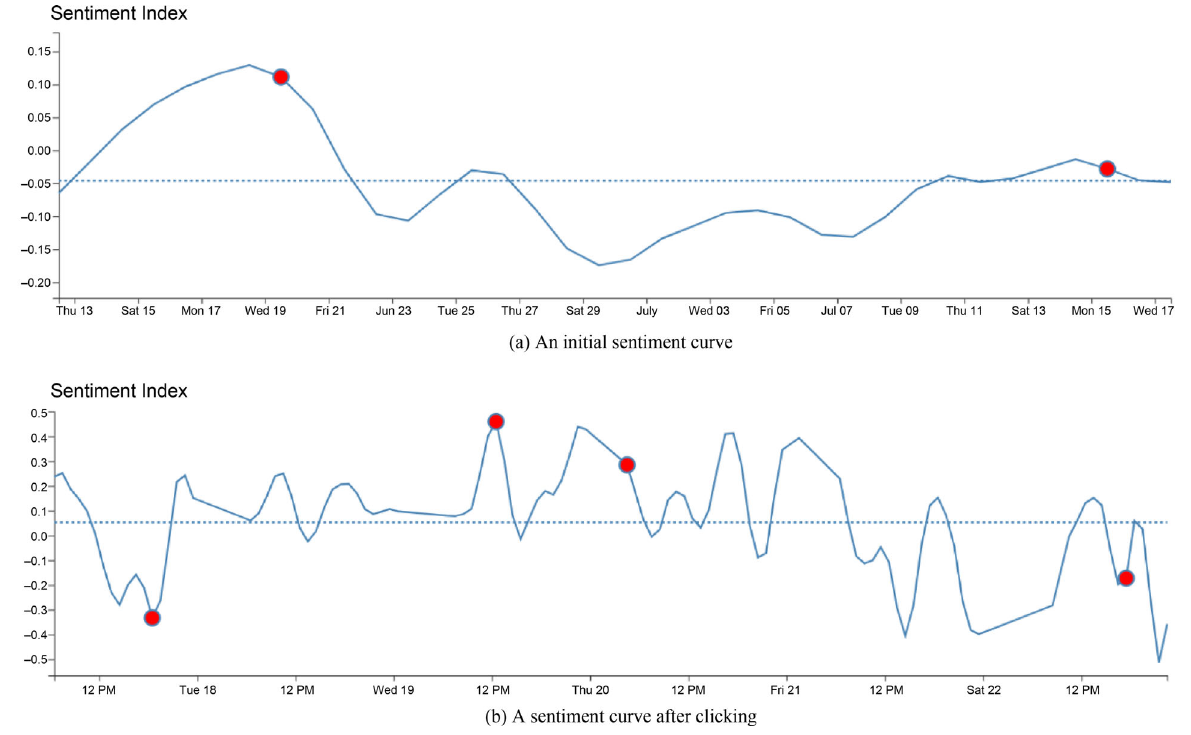
Fig. 3 Sentiment curve